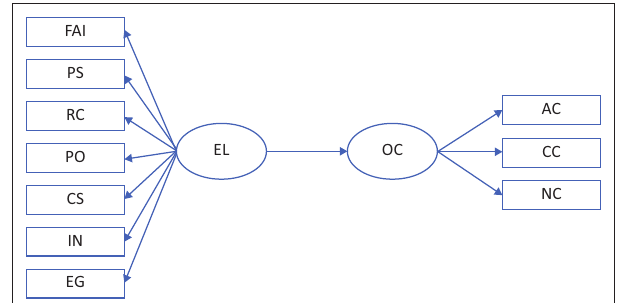
FIGURE 1: Proposed conceptual